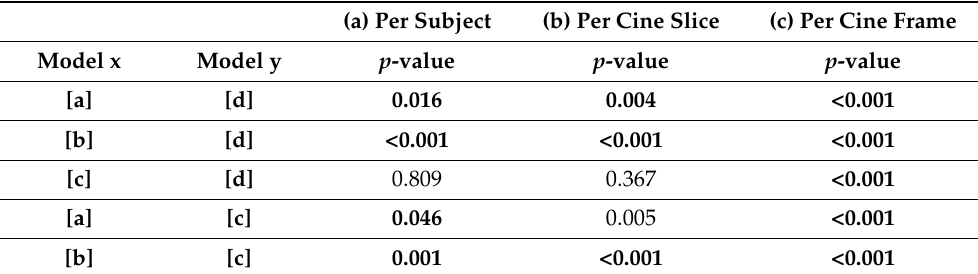
Table 3. Wilcoxon signed-rank tests to compare models using Dice Score distribution pattern per subject (a), per cine slice (b) and per cine frame (c) of the comparison study results in five-fold cross-validations using different methods.